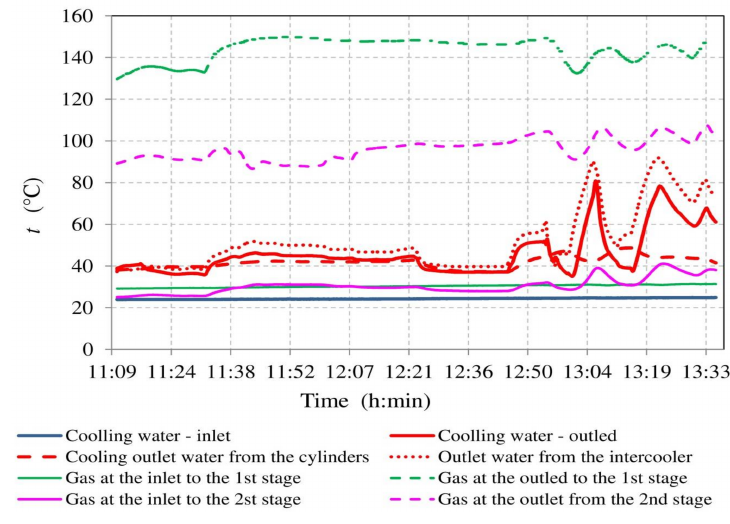
Figure 4. Curves of the measured